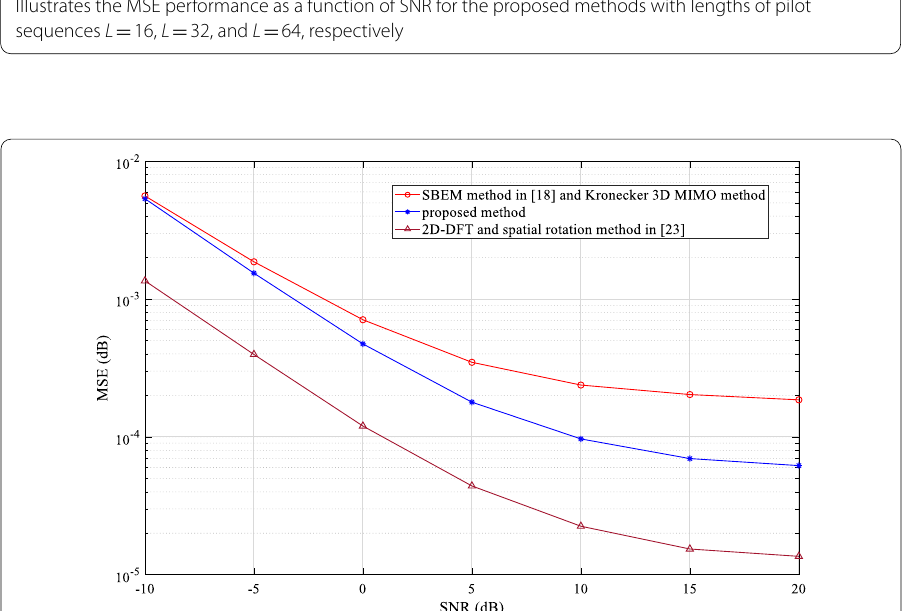
16, 32, and 64, respectively. =